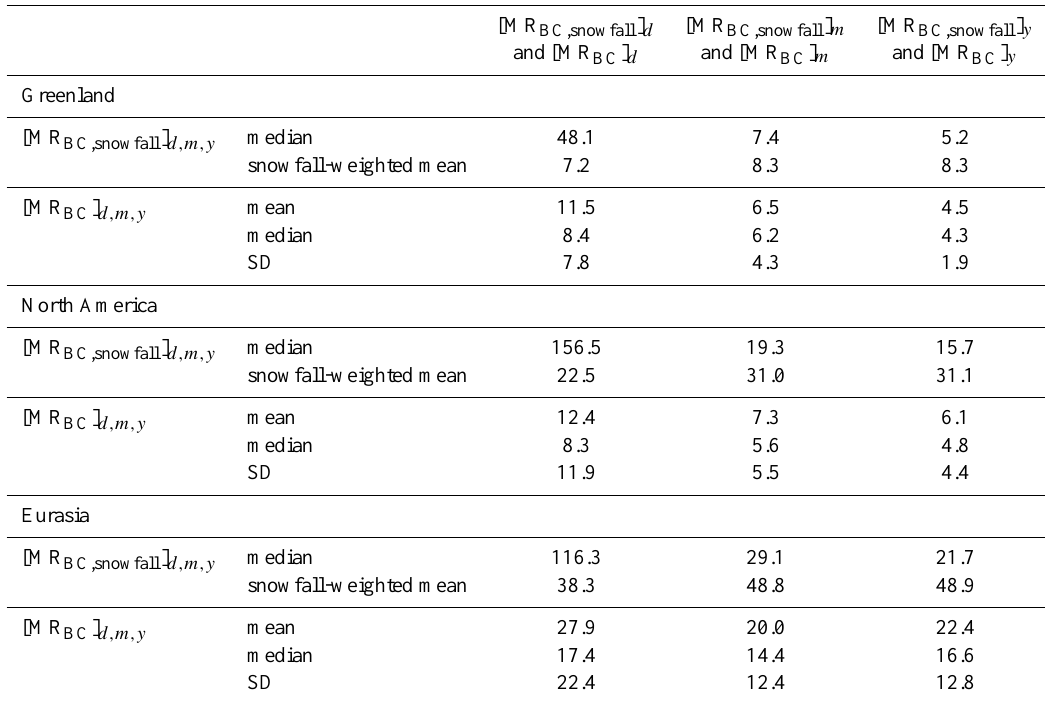
Table 3. Means, medians and standard deviations of BC mixing ratios in snowfall (MR BC,snowfall ; ngg − 1 ) and in the surface snow layer (MR BC ; ngg − 1 ) from offline calculations using CESMmet, as described in the text. Also shown is the mean of MR BC,snowfall after weighting by the snowfall amount in snow-water equivalent. The arithmetic mean and standard deviation of [MR BC,snowfall ] d are not given because it includes infinite mixing ratios (i.e., when snowfall is zero) and so these are not finite values. [MR BC,snowfall ] d [MR BC,snowfall ] m [MR BC,snowfall ] y and [MR BC ] d and [MR BC ] m and [MR BC ]